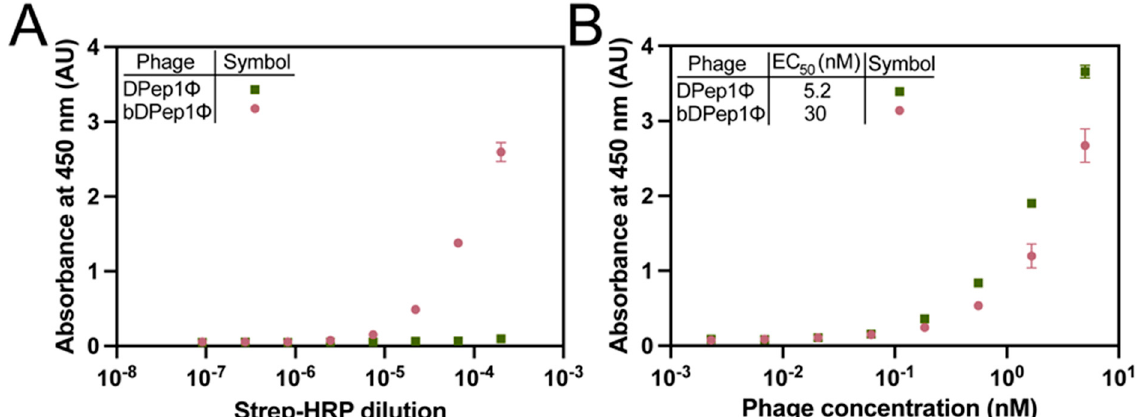
Figure 2. Efficient phage biotinylation and its effects on target binding. ( A ) Biotinylation of phages (bDPep1 Φ ) was confirmed via direct detection ELISA with peroxidase-conjugated streptavidin (Strep-HRP) assay. ( B ) An indirect phage ELISA with DJ-1 verified that both biotinylated and non- biotinylated page (DPep1 Φ ) could bind the target antigen despite biotinylation. ELISA data were fit to a four-parameter logistic curve. Error bars indicate standard deviation ( n = 3); each data point includes error bars, although most are quite small. HRP = horseradish peroxidase.